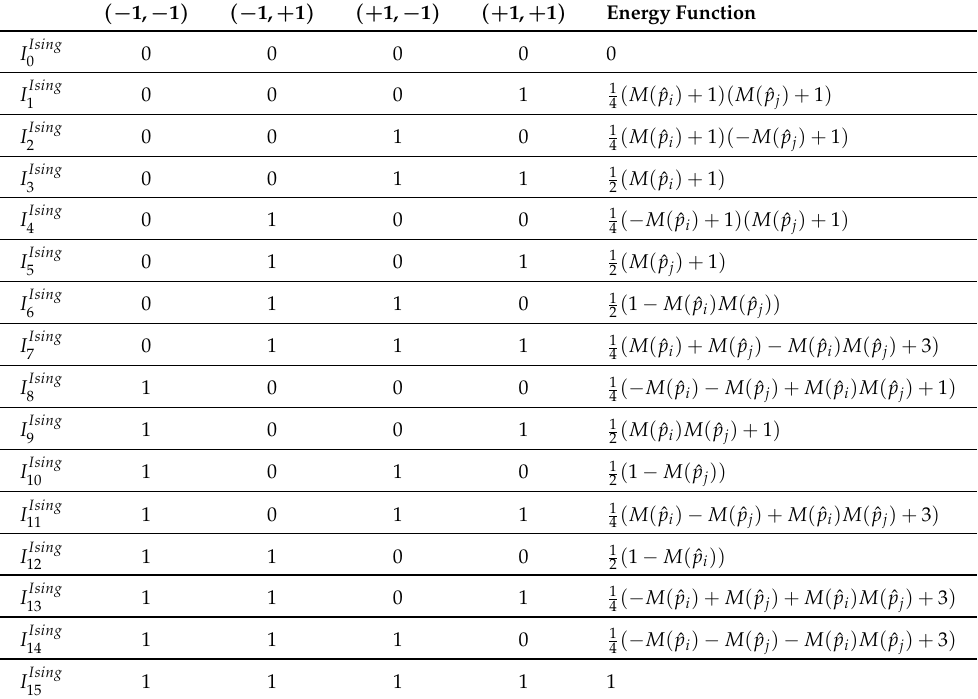
Table A2. Interaction Primitives in Ising